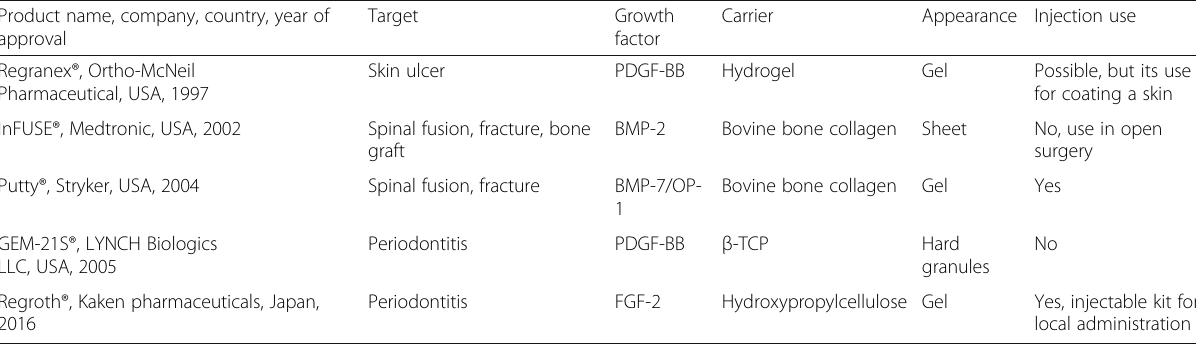
Table 2 Commercially available growth factor-containing products for local application Product name, company, country, year of